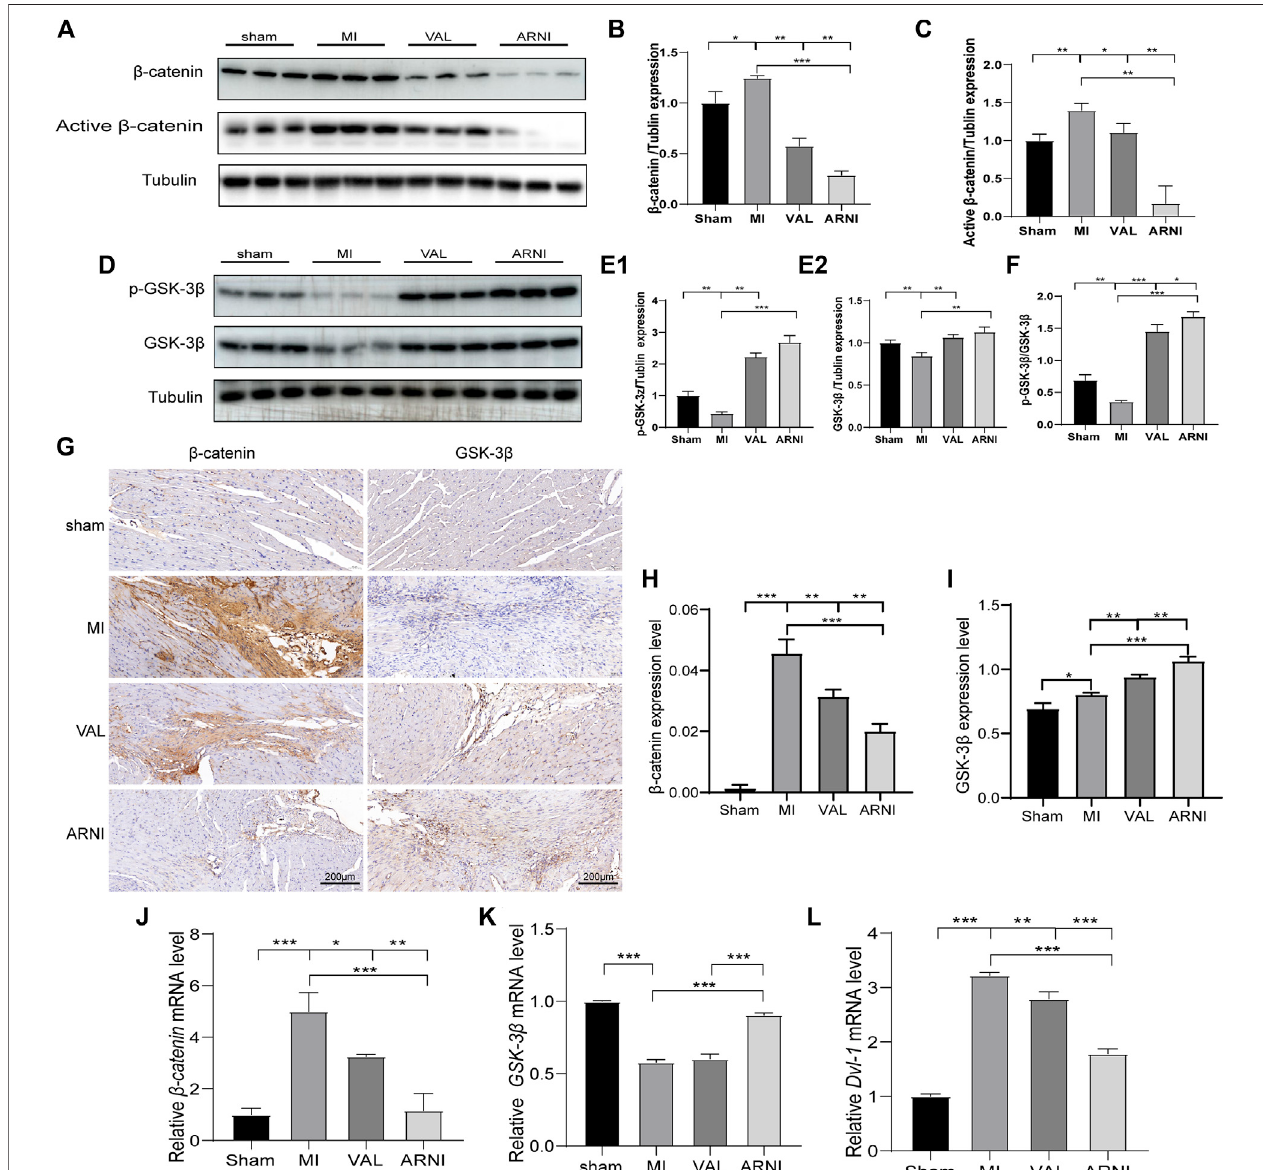
FIGURE 4 | The in fl uence of the Wnt/ β -catenin signaling pathway in mice with MI. (A,B,C). Western blot analysis of the β -catenin and active β -catenin expression. (D,E1,E2,F) . Western blot analysis of the GSK-3 β and p -GSK-3 β expression. G. Immunohistochemistry staining of β -catenin and GSK-3 β . (H, I) β -catenin and GSK-3 β Immunohistochemistry quantitative data. (J,K,L) Relative mRNA expression level of β -catenin , GSK-3 β and Dvl-1 . Each group n (cid:1) 7. * p < 0.01,** p < 0.05, *** p < 0.001.